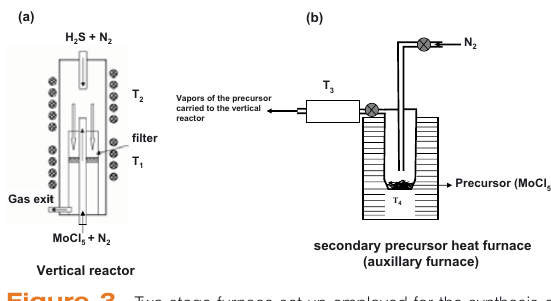
Figure 3. Two-stage furnace set-up employed for the synthesis of the IF-MoS nanoparticles. (a) Vertical reactor and (b) 2 the secondary precursor heat furnace (auxiliary furnace) (adapted from Ref.